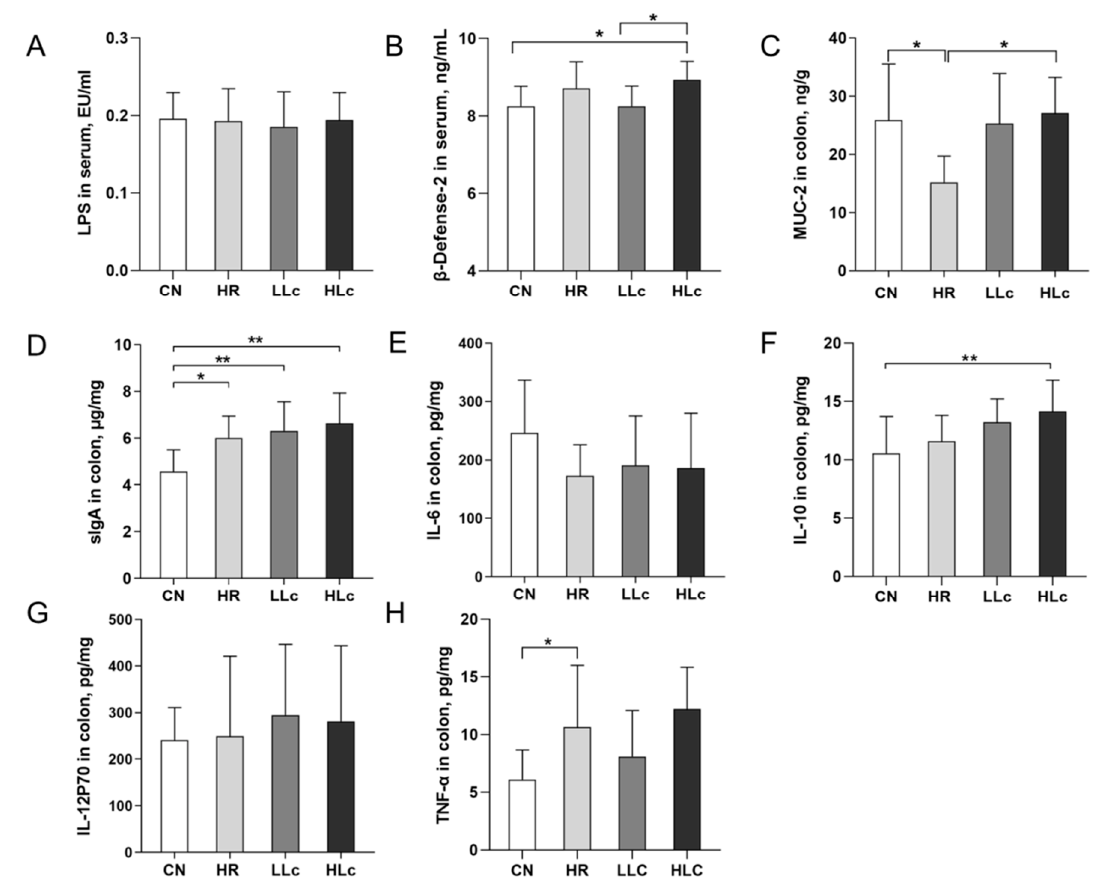
Figure 2. The Effects of anti-TB drugs and Lactobacillus casei on colonic immunity and inflammation-related factors. ( A ) LPS in serum, n = 10 per group. ( B ) β -defensin-2 in serum, except the CN group n = 8, the other groups n = 10. ( C ) Colonic mucus MUC-2 in colon, except the LLc group n = 8, the other groups n = 10. Immune and inflammatory factors in the colon:( D ) sIgA, ( E ) IL-6, ( F ) IL-10, ( G ) IL-12 p70, ( H ) TNF- α . n = 10 per group. Values are mean ± SD. LPS: lipopolysaccharide, MUC-2: Member of the mucin family, sIgA: secretory IgA, IL-6: interleukin-6, IL-10: interleukin-10, IL-12p70: interleukin-12 p70. CN: control group, HR: isoniazid + rifampicin model group, LLc: HR + low dose L. casei ATCC334 group, HLc: HR + high dose L. casei ATCC334 group. * indicates p < 0.05, ** indicates p <